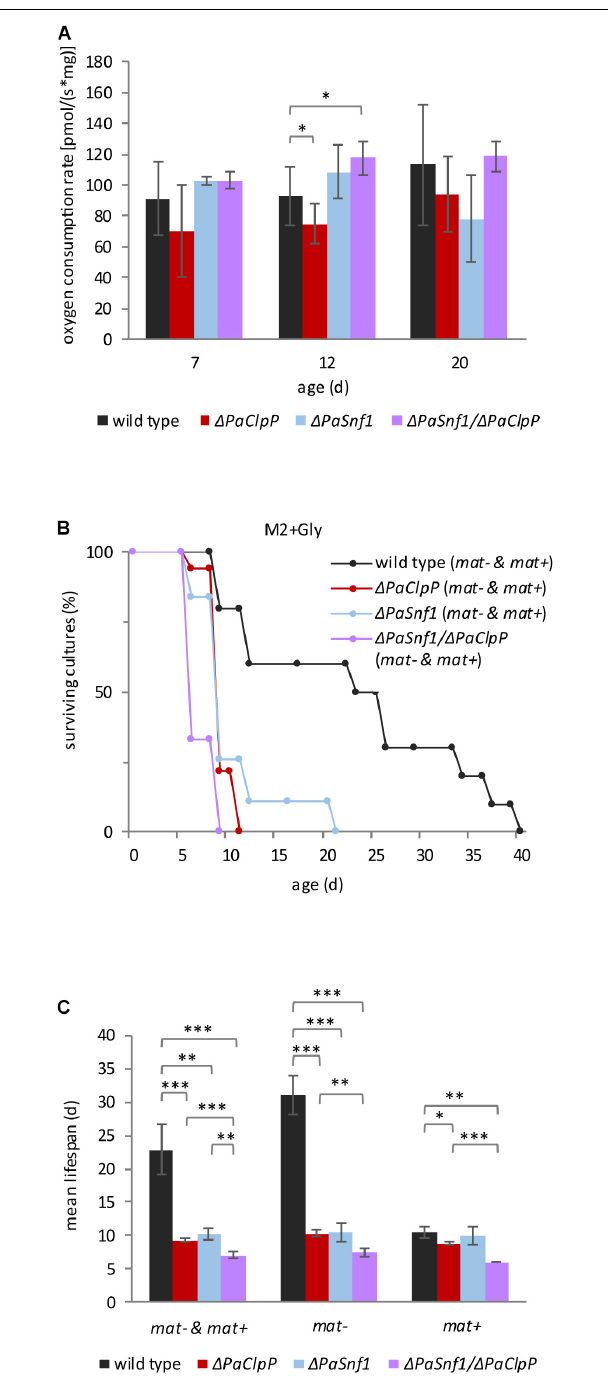
FIGURE 6 | Lack of PaSNF1 does not significantly affect oxygen consumption and impairs growth on glycerol. (A) Oxygen consumption rate (OCR) of mycelium from 7-, 12-, and 20-day-old (cid:49) PaSnf1 , (cid:49) PaClpP , (cid:49) PaSnf1 / (cid:49) PaClpP , and wild type. [7 days: (cid:49) PaSnf1 ( n = 3), (cid:49) PaClpP ( n = 6), (cid:49) PaSnf1 / (cid:49) PaClpP ( n = 4), and wild type ( n = 12) // 12 days: (cid:49) PaSnf1 ( n = 4), (cid:49) PaClpP ( n = 6), (cid:49) PaSnf1 / (cid:49) PaClpP ( n = 4), and wild type ( n = 13) // 20 days: (cid:49) PaSnf1 ( n = 3), (cid:49) PaClpP ( n = 6), (cid:49) PaSnf1 / (cid:49) PaClpP ( n = 3), and wild type ( n = 10)]. The values presented are mean ± SD. (B)